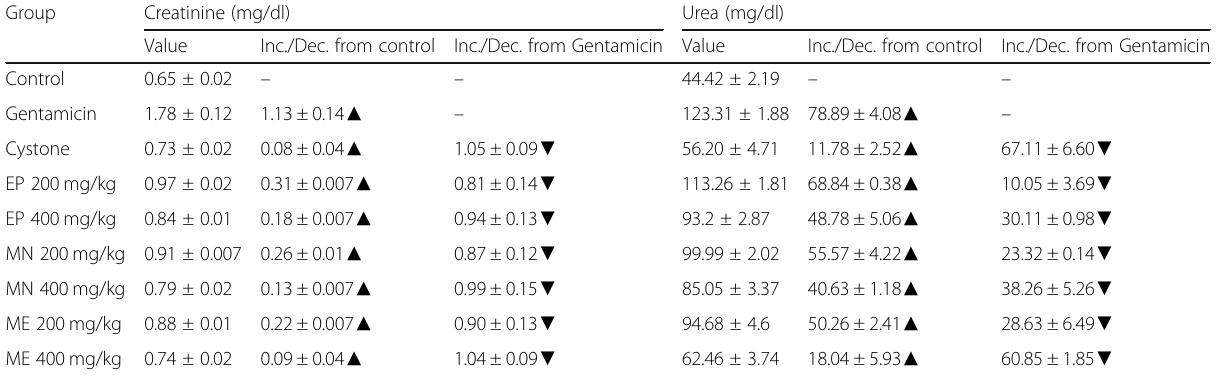
Table 2 Effects of three actinorhizal fruits on serum biochemical parameters of nine ( n = 9) treated groups Group